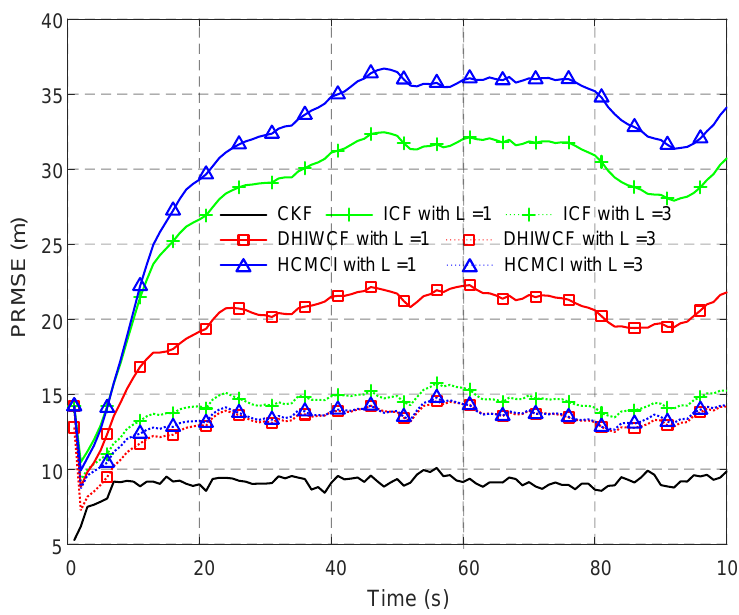
Figure 9. The averaged PRMSE for distributed algorithms with different consensus iterations.